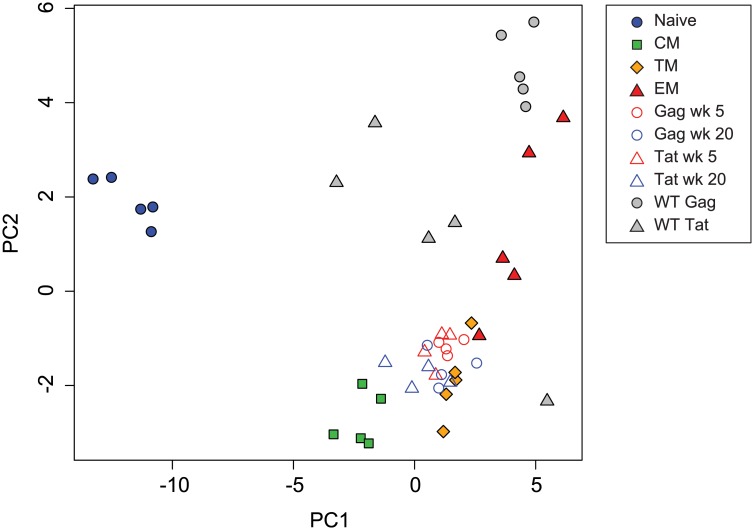
Principal component analysis of transcription factor expression profiles from SIV-specific MHC tetramer-sorted CD8+ T cells from animals vaccinated with SIVΔnef, animals infected with wild-type SIV, and sorted CD8+ T cell subsets.Plot of principal components 1 and 2 for each of the expression profiles assessed from sorted naïve and memory CD8+ T cell subsets, SIV-specific MHC tetramer-sorted CD8+ T cells isolated from SIVΔnef-vaccinated animals, and MHC tetramer-sorted CD8+ T cells isolated from animals (n = 5) at 20 weeks following wild-type SIV infection. Principal components 1 and 2 explain 77 percent of cumulative total variance.